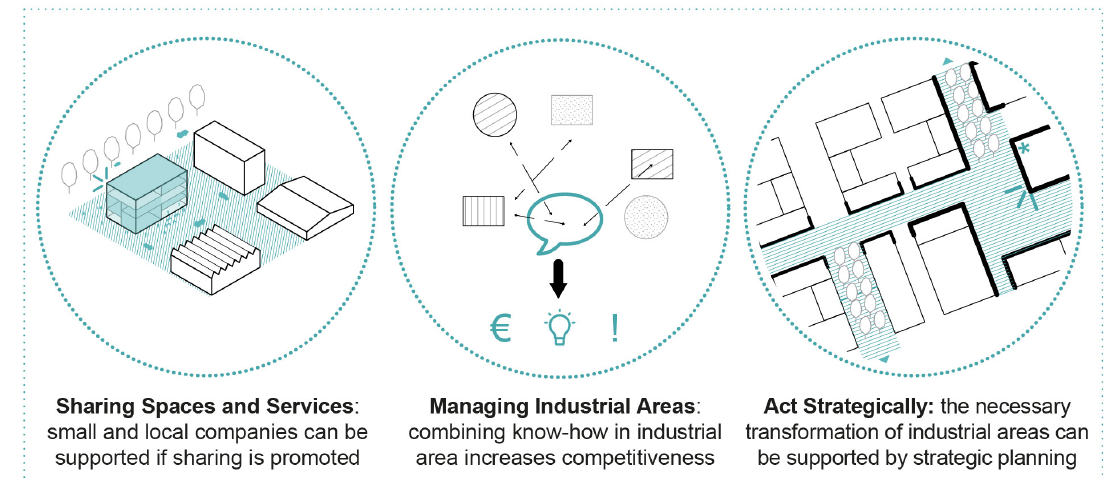
Figure 7. Scales of strategic urban planning (marked in green; see descriptions in Subsections